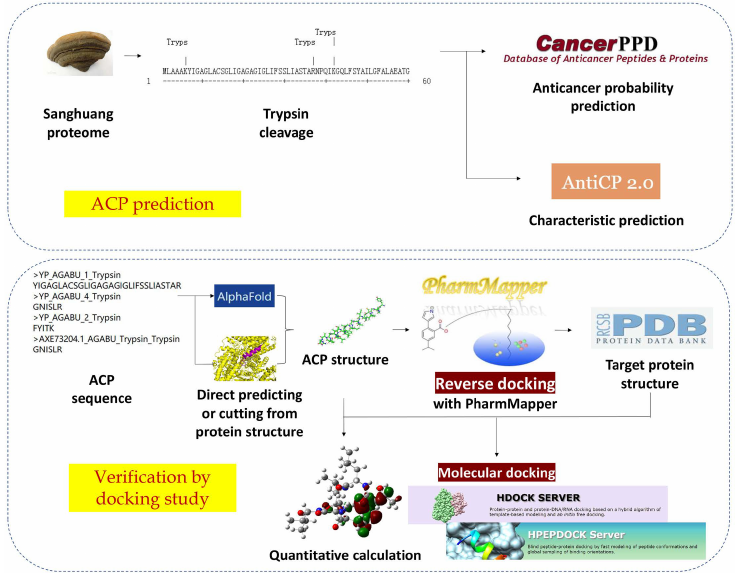
Figure 1. Schematic illustration of the steps involved in the in silico discovery of Sanghuang